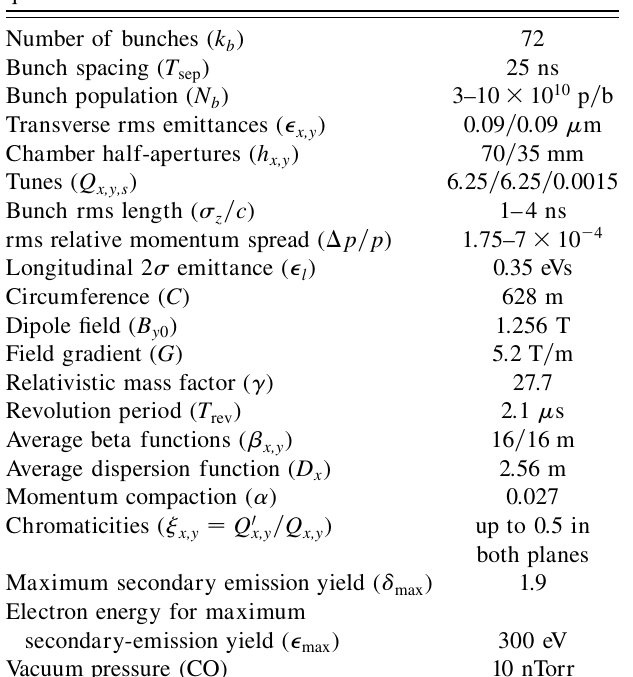
TABLE I. PS parameters used in the simulations. As far as the beam emittance is concerned, the rms physical value is quoted